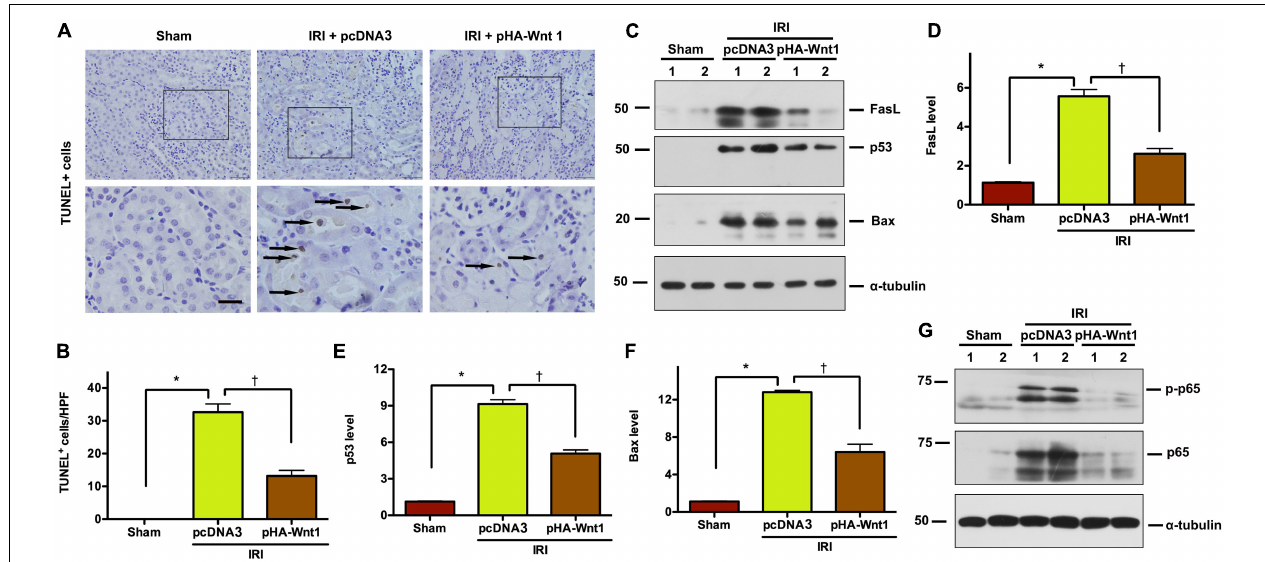
FIGURE 2 | In vivo expression of exogenous Wnt1 before IR reduces tubular cell apoptosis and NF- κ B activation in AKI mice. (A) Representative micrographs show TUNEL-positive cells in different groups as indicated. Arrows indicate positive staining. Scale bar, 100 µ m. (B) Graphic presentation shows the TUNEL-positive cells per high power field (HPF) in different groups as indicated. (C–F) Representative Western blot analyses show renal expression of FasL, p53, and Bax in different groups as indicated. * P < 0.05 versus Sham controls; † P < 0.05 versus IRI injected with pcDNA plasmids ( n = 5–6). (G) Representative Western blot of p65 and p-p65 proteins in different groups as